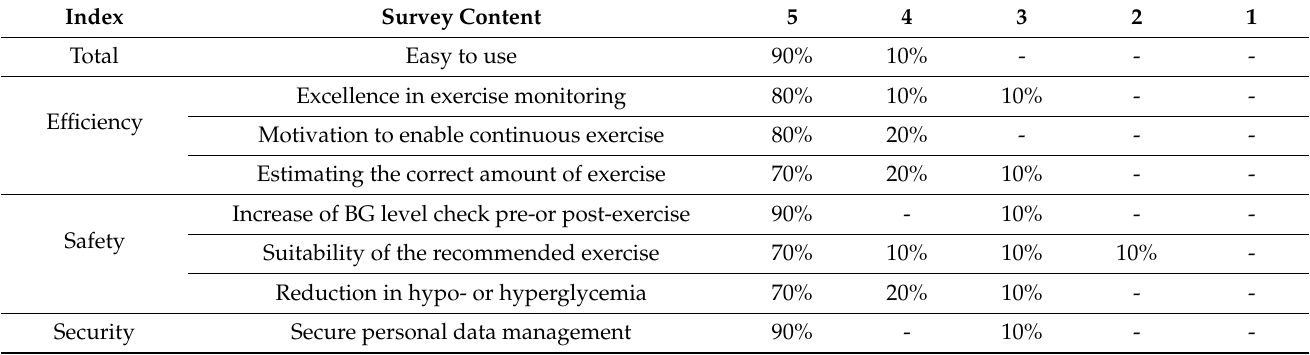
Figure 14. Questions for users to rate the application. Table 7. Survey results for characteristics of the proposed self-management IoT